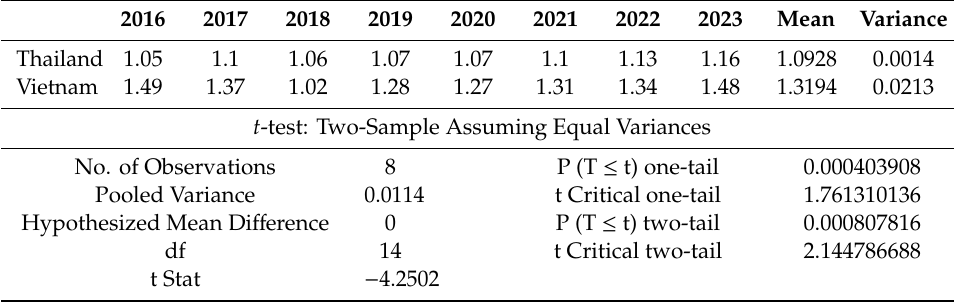
Table 10. Results of t -test of the e ffi ciency scores over the period of 2016 to 2023.